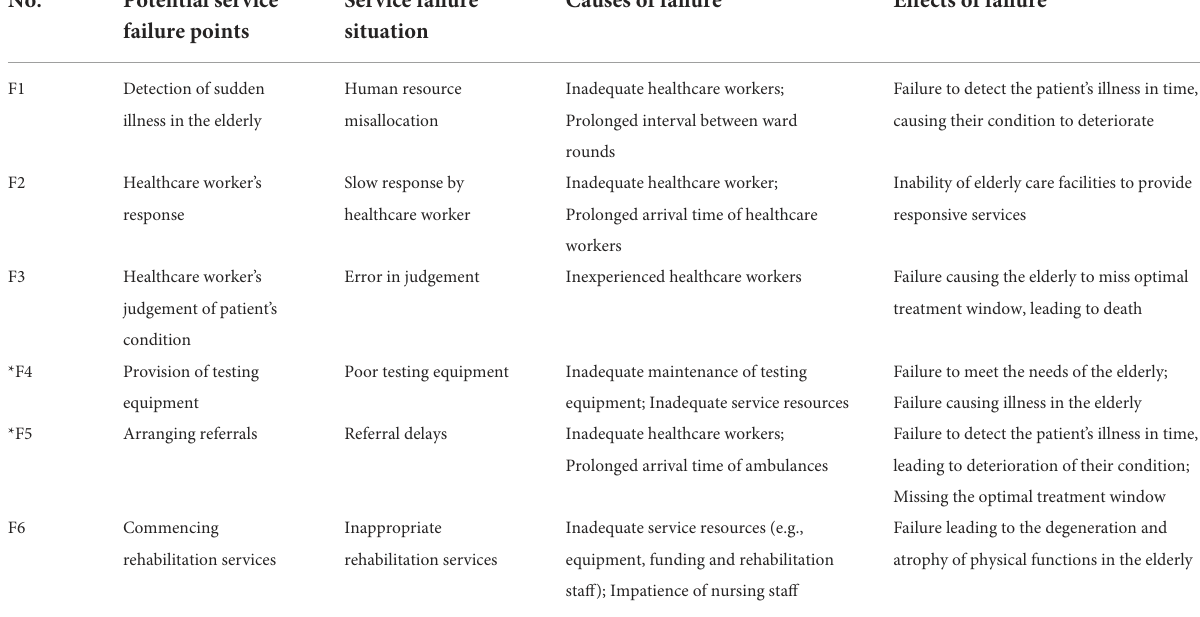
*F4isaservicefailureuniquetominorillnesses,and *